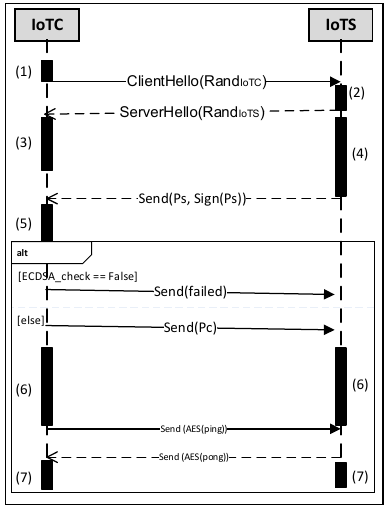
Figure 2. Transport Layer Security (TLS) Handshake